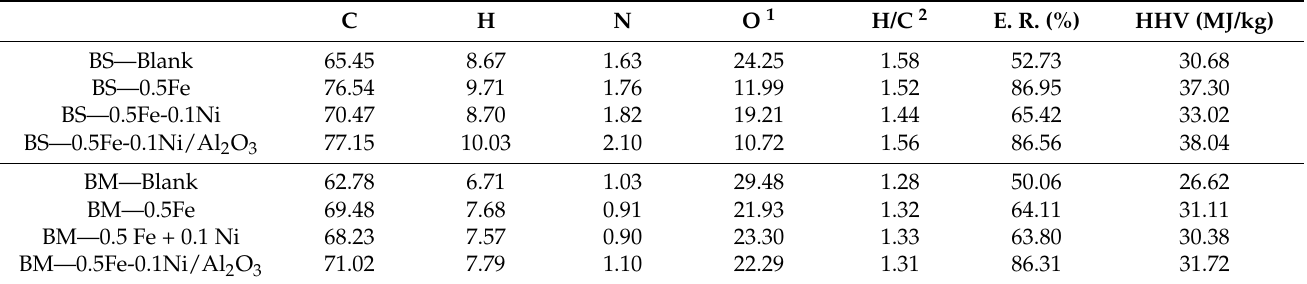
Table 2. Elemental analysis of BS and BM raw material and bio-crudes obtained at 330 ◦ C for a residence time of 10